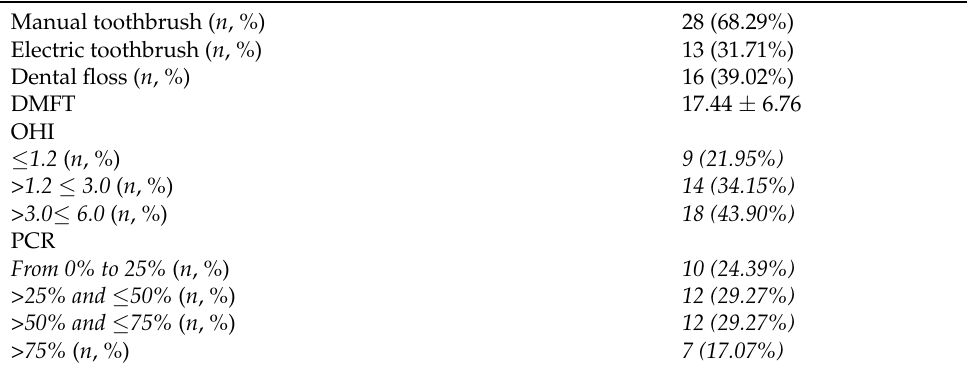
Table 3. Oral hygiene status in the study population ( n =